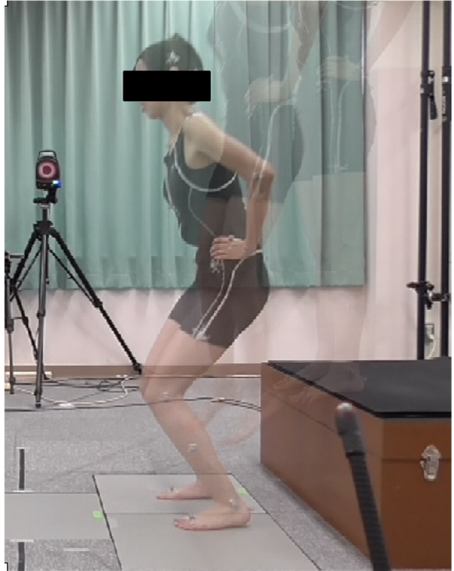
Figure 1. A drop vertical jump and the experimental setup.